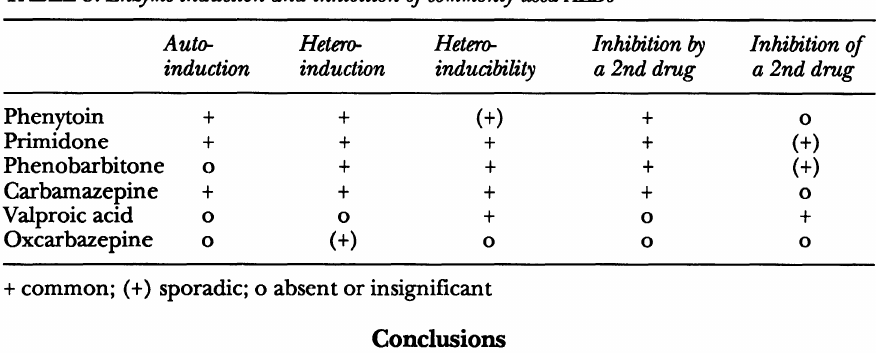
TABLE 3. Enzyme induction and inhibition of commonly used AEDs Auto- Hetero- Hetem- Inhibition Uy induction induction inducibility a2nddmg